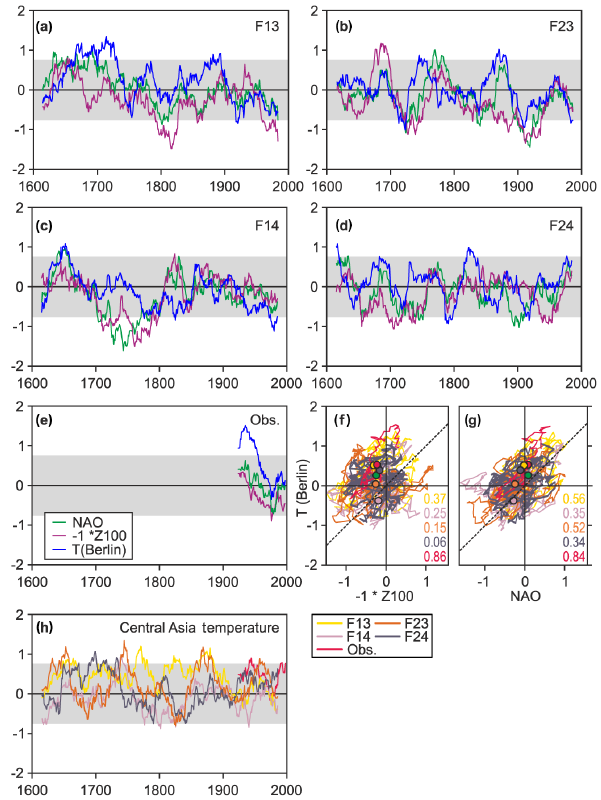
Figure 4. Standardized differences between easterly minus westerly QBO phases in 30-year moving windows for NAO, Z100 and Berlin SAT in the four model simulations (a) F13, (b) F14, (c) F23 and (d) F24 and in (e) observation-based data (Z100 from reconstruc- tions, NAO from 20CRv2c). Panels (f) and (g) show the same time series but plotting Berlin SAT as a function of − 1 · Z100 or NAO (filled circles indicate the standardized difference over the entire period and numbers give the correlations; the green circles indicate the standardized differences from ERA-Interim, 1979–2015; one- to-one lines are dashed). Panel (h) shows standardized differences between easterly minus westerly QBO phases in 30-year moving windows for the Central Asia SAT index in HadCRUT4v and in the model simulations. Grey shading denotes an approximate 95% confidence interval for 30-year